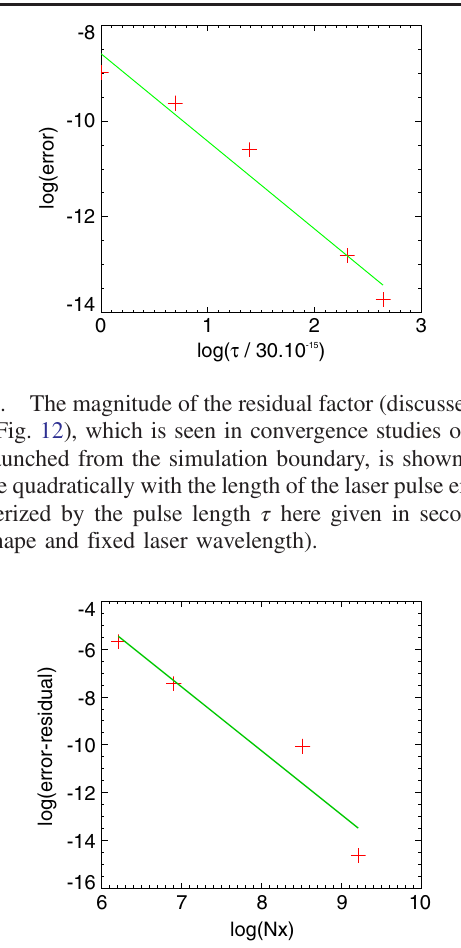
FIG. 14. Analogous to Fig. 12 above, except here the paraxial laser pulse was launched at an angle from the right-hand surface of the simulation domain, and then compared with the analytic form after it has propagated onto the mesh. As before, it is required that one subtract from the error a residual constant that depends upon details of the laser pulse length and